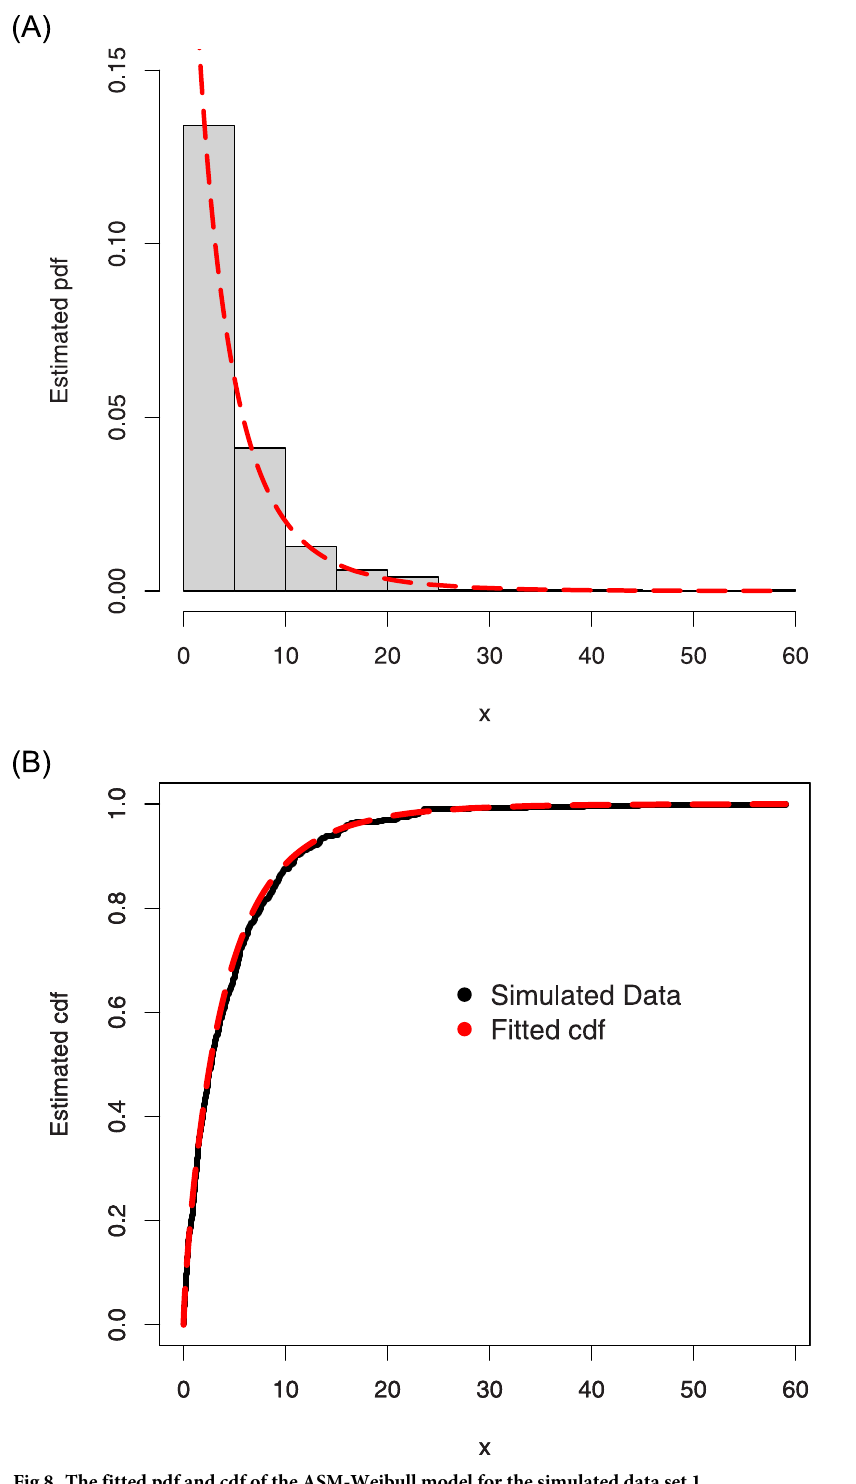
Fig 8. The fitted pdf and cdf of the ASM-Weibull model for the simulated data set 1.